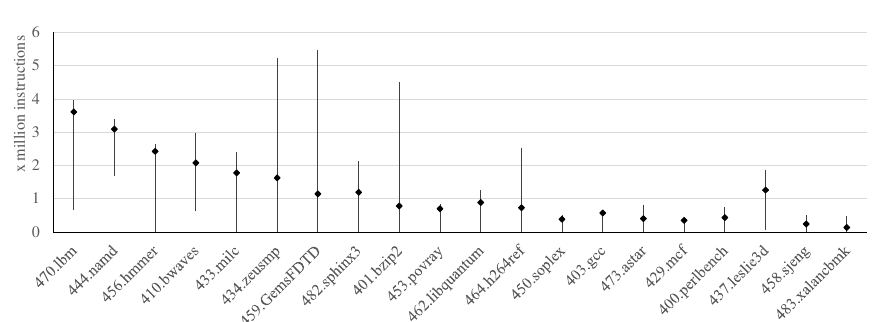
( b ) The average, maximum, and minimum lengths of epochs. The top and bottom of each vertical line represent the maximum and minimum lengths of the epochs (the number of instructions to be simulated per epoch) in a benchmark, respectively. The dot indicates the average length of the epochs in a benchmark.